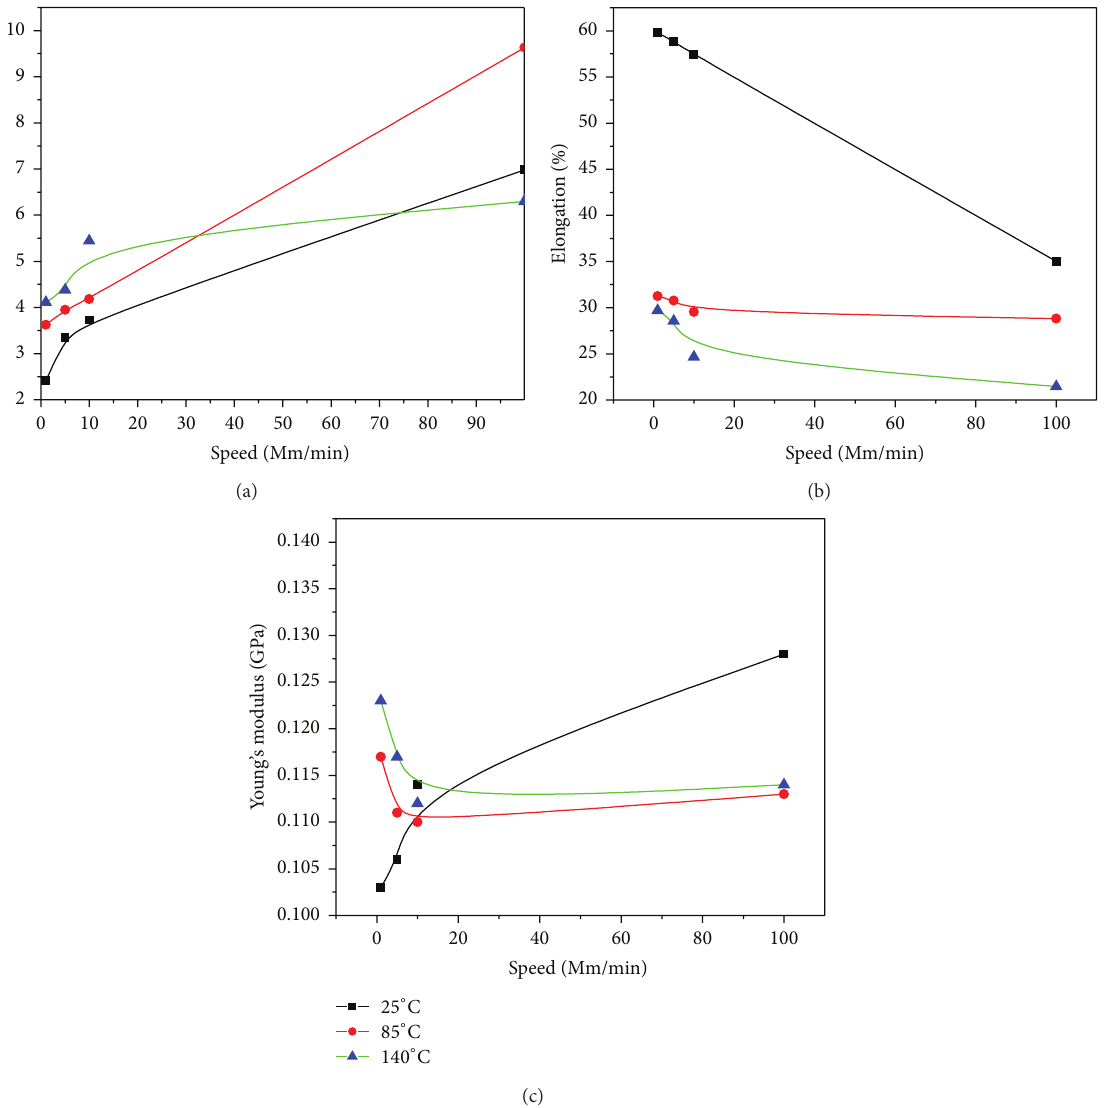
Figure 6: (a) The variation of the mechanical properties; yield strength of the PVA films with the speed at different temperatures. (b) The variation of the mechanical properties; elongation % of the PVA films with the speed at different temperatures. (c) The variation of the mechanical properties; Young’s modulus of the PVA films with the speed at different